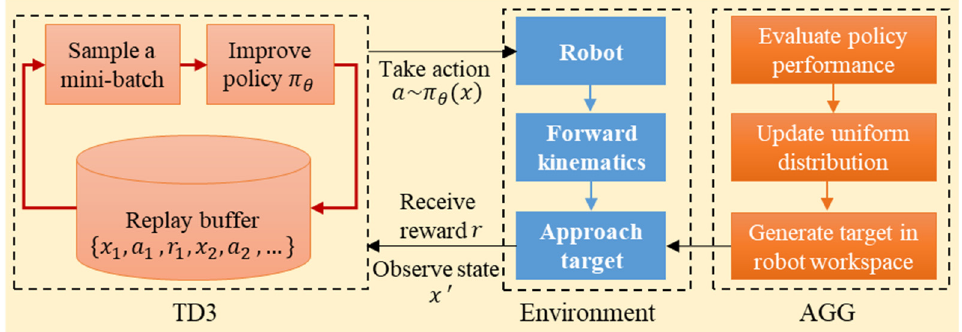
Figure 1. Flowchart of TD3 + AGG. TD3 alternately collects transitions through exploration in the robot environment and uses a subset of transitions to optimize the IK policy. Meanwhile, AGG gen ‐ erates random targets for the environment to encourage TD3 to explore the entire robot workspace progressively.